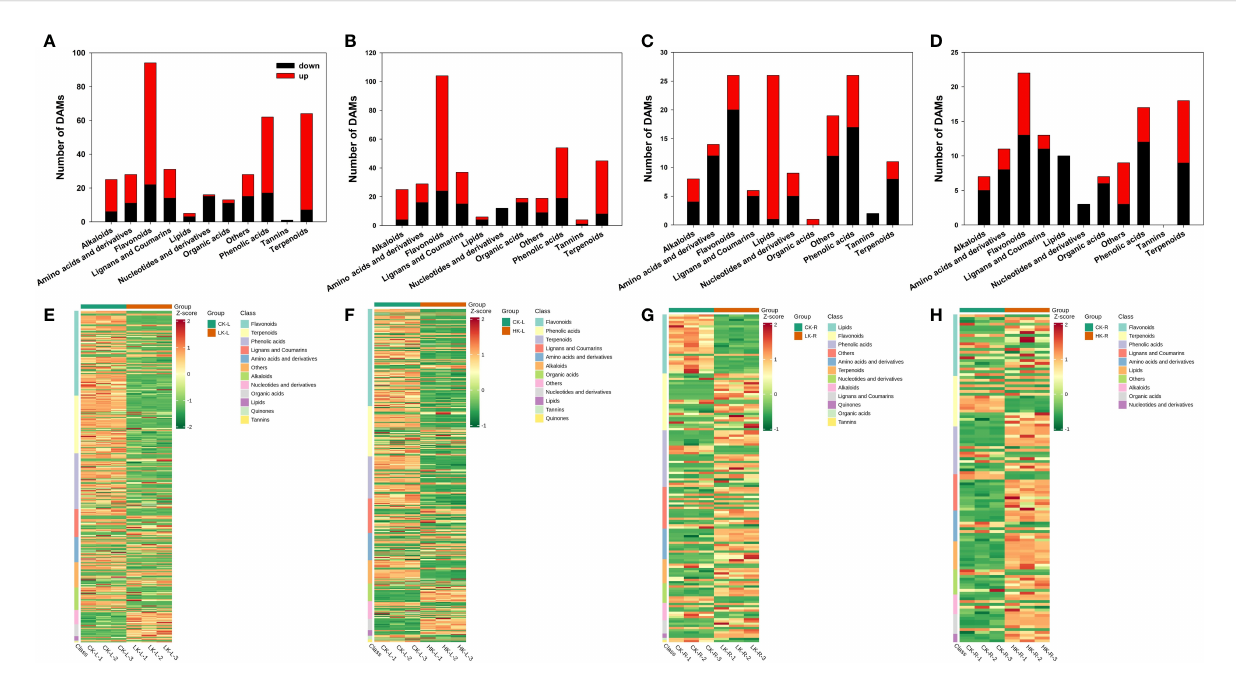
FIGURE 3 Differentially accumulated metabolites among different potassium treatments in apple. (A, E) Major classes of detected metabolites and heatmaps of differential metabolites between LKL/CKL. (B, F) Major classes of detected metabolites and heatmaps of differential metabolites between HKL/CKL. (C, G) Major classes of detected metabolites and heatmaps of differential metabolites between LKR/CKR. (D, H) Major classes of detected metabolites and heatmaps of differential metabolites between HKR/CKR. Three independent replicates of each stage are also displayed in the